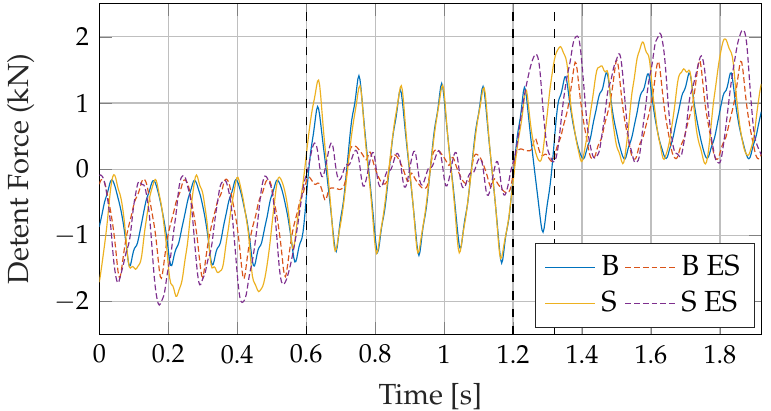
t = 1.32 s and t = 1.2 s, respectively, indicated by the dashed vertical lines. The different phases are indicated by different colors.